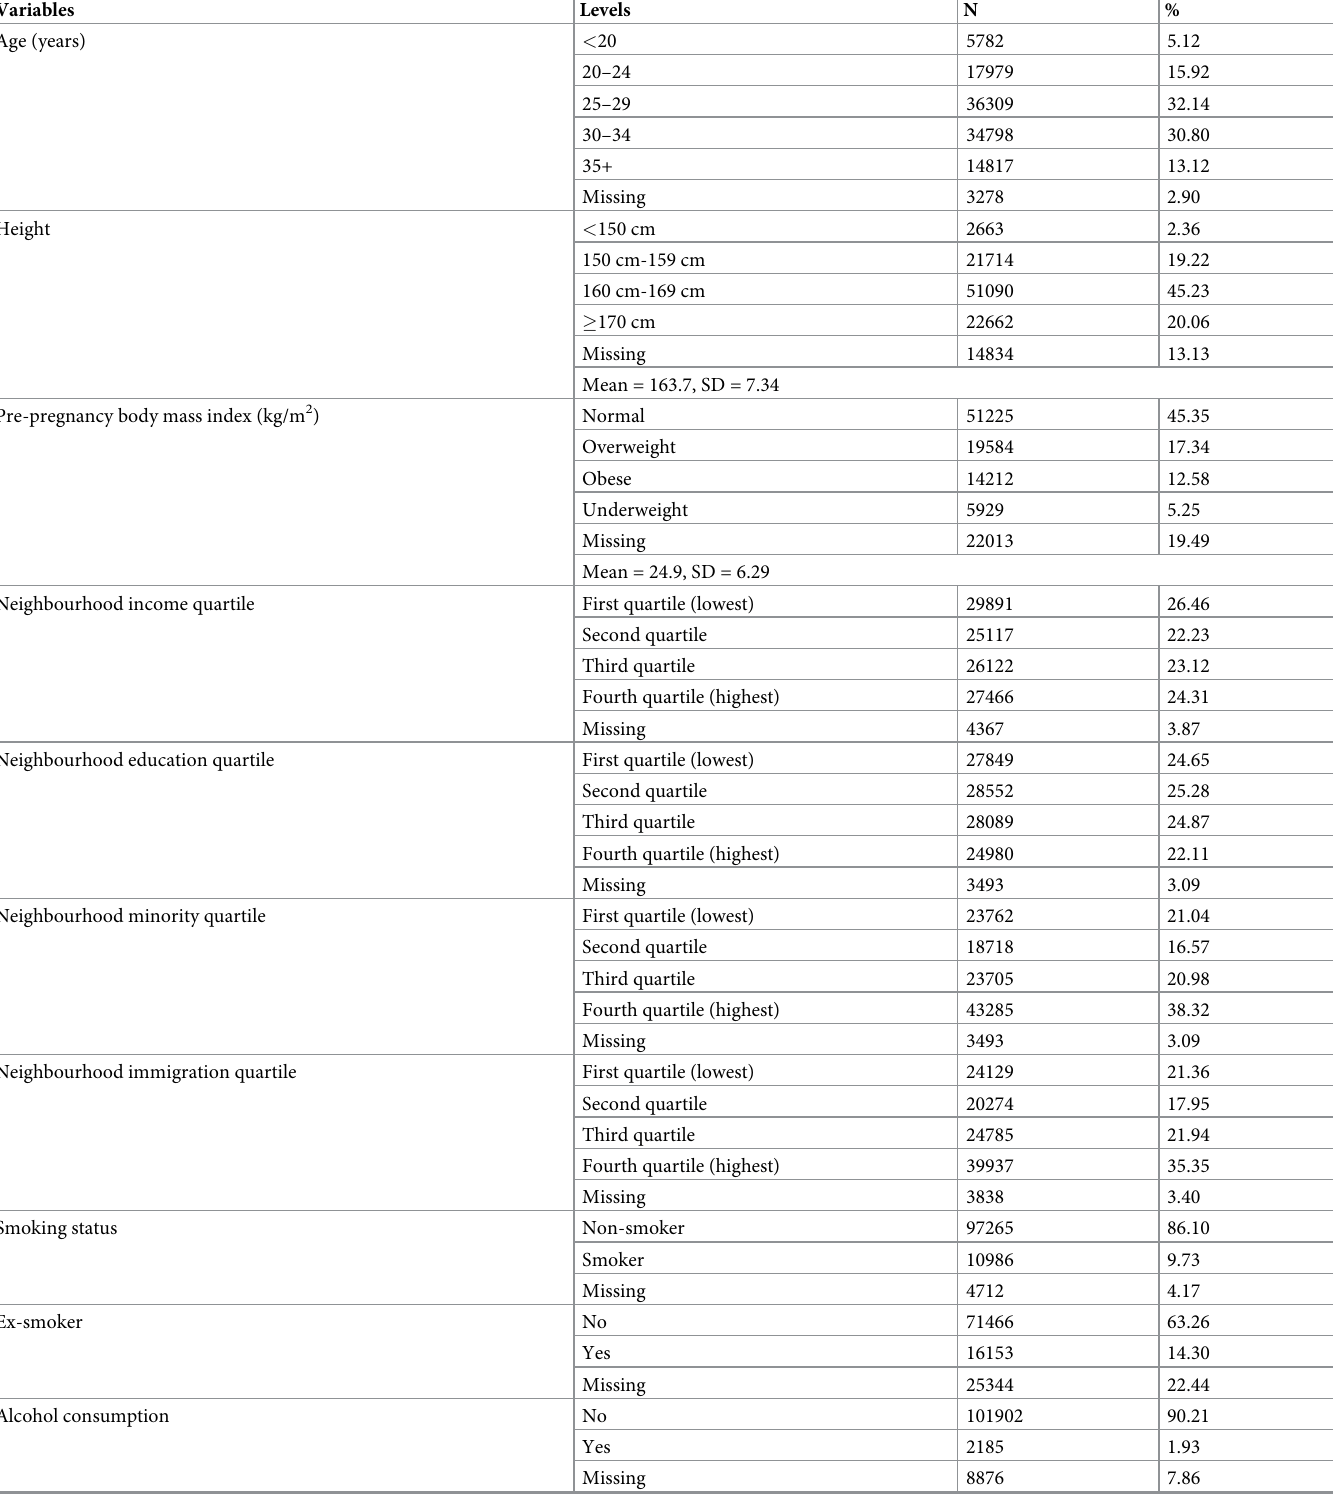
Table 1. Distribution of maternal baseline characteristics, demographics, and clinical variables in nulliparous